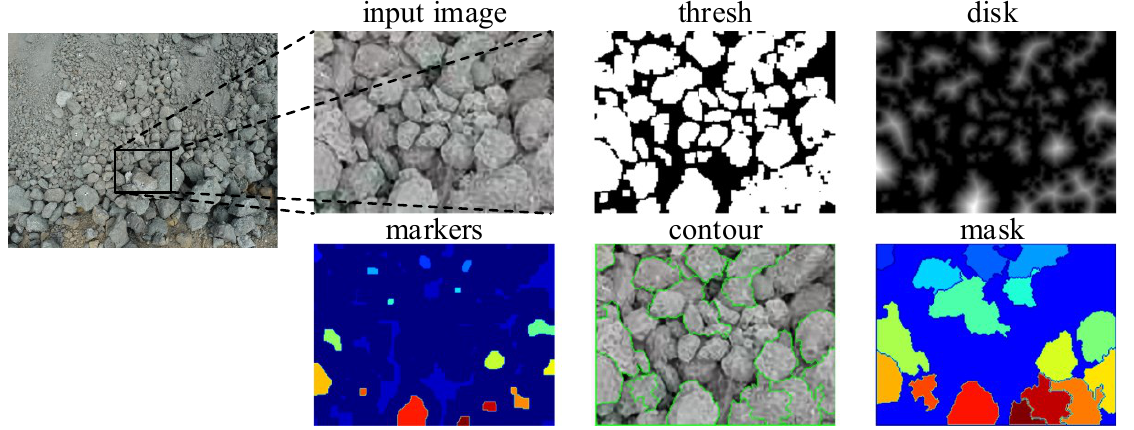
Figure 1. Illustration of the watershed algorithm. The image is the original input image. Thresh is the result of a grayscale binarization process. Dist is the result of the distance function processing. Maker is to extract the foreground information. Contour is the result of finding the object. Mask is the result of the final